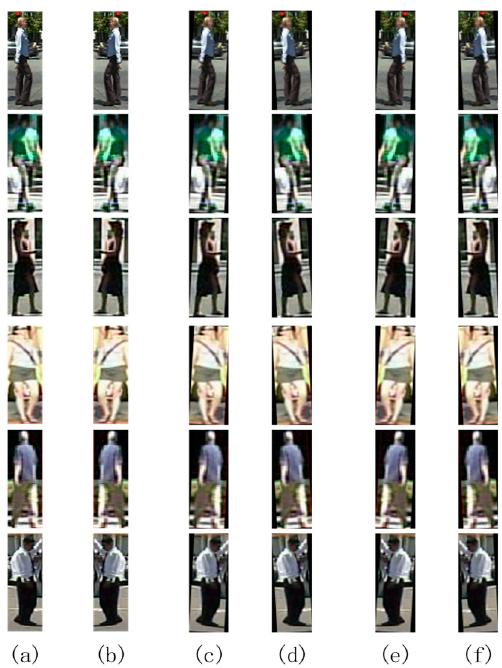
Figure 7. The examples of positive sample augmentation. ( a ) Origin images; ( b ) images after a mirror flip; ( c ) images with a clockwise rotation of three degrees; ( d ) images with a counterclockwise rotation of three degrees; ( e ) mirrored images with a clockwise rotation of three degrees; ( f ) mirrored images with a counterclockwise rotation of three degrees.